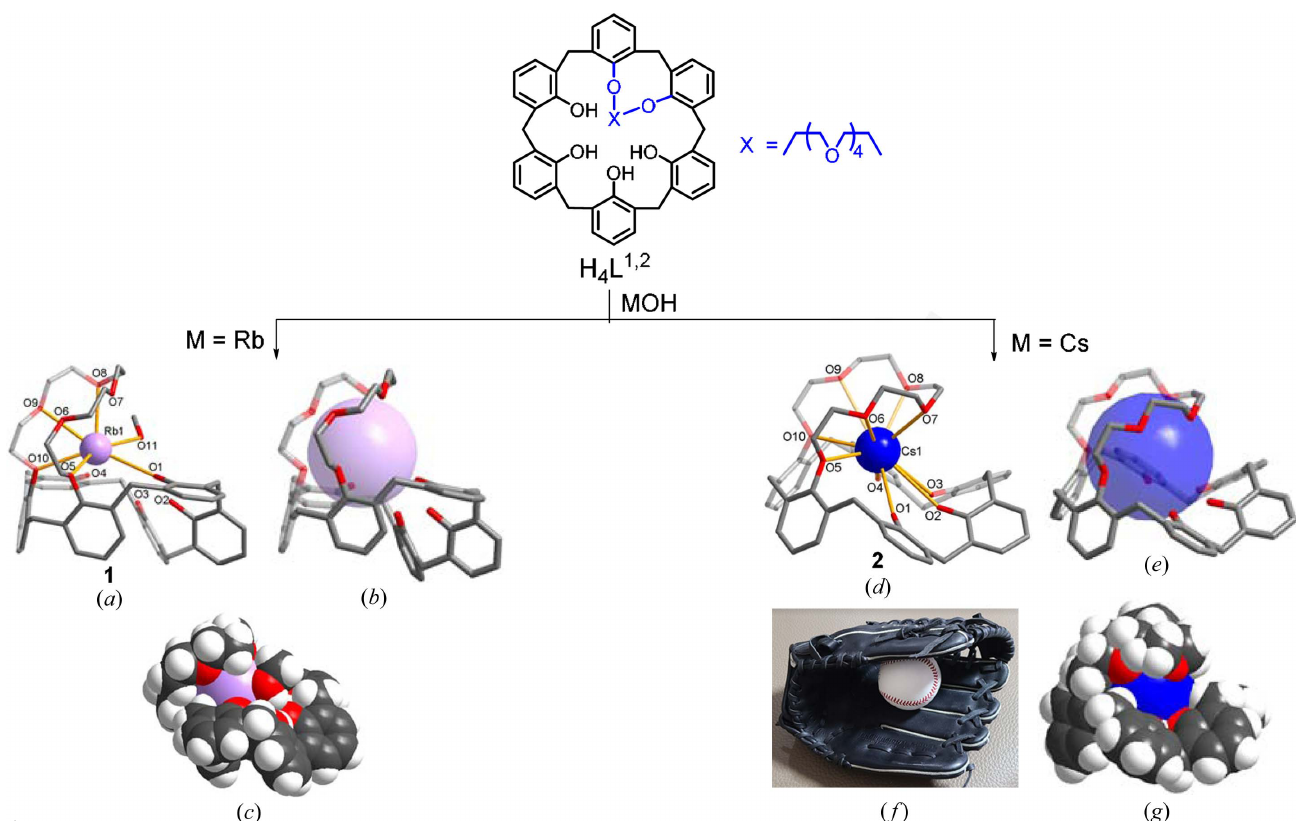
Figure 1 ( a ) Formation of the rubidium(I) complex of H 4 L 1,2 , [Rb(H 3 L 1,2 )(CH 3 OH)] ( 1 ) showing a six-coordinated environment; ( b ) loose capture of Rb + ; and ( c ) space-filling structure. ( d ) Formation of the caesium(I) complex of